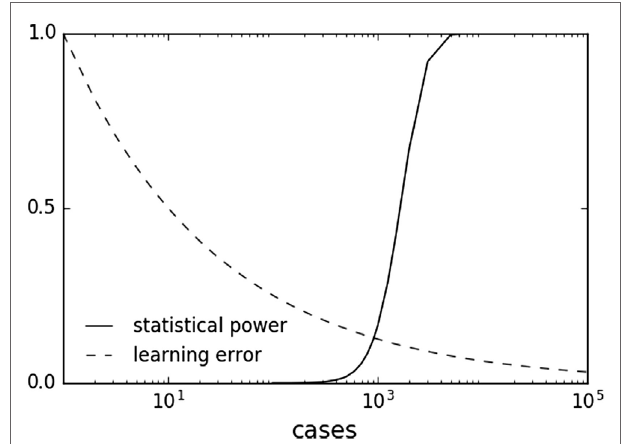
FiGURe 3 | Sample plots of statistical power and learning curve error. Statistical power graph derived using Genomic Association Studies power calculator (137). Learning curve assuming an inverse power law common to multiple machine learning methods (80, 139,